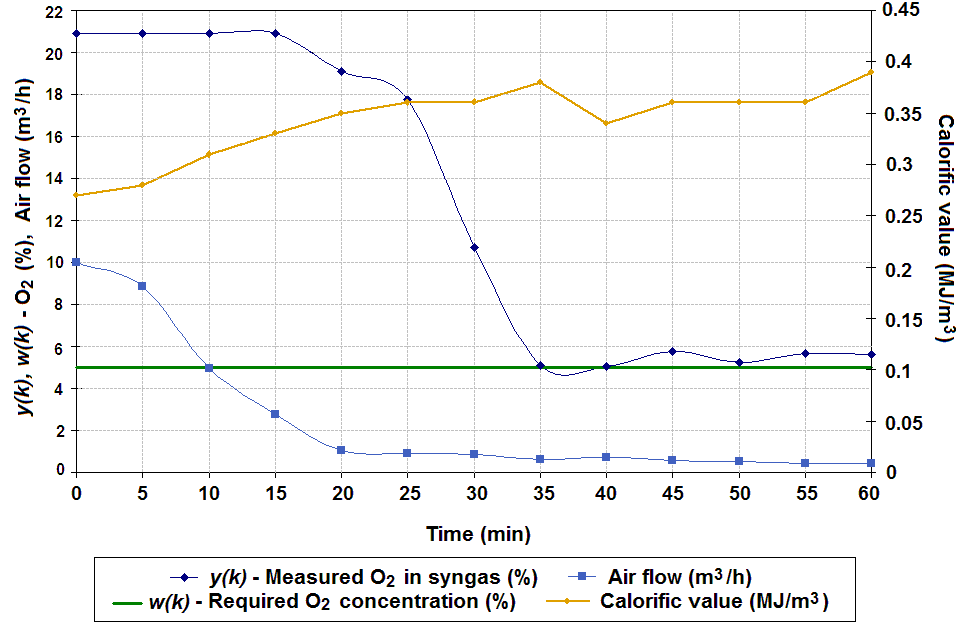
Figure 5. Oxygen stabilization via regulated airflow